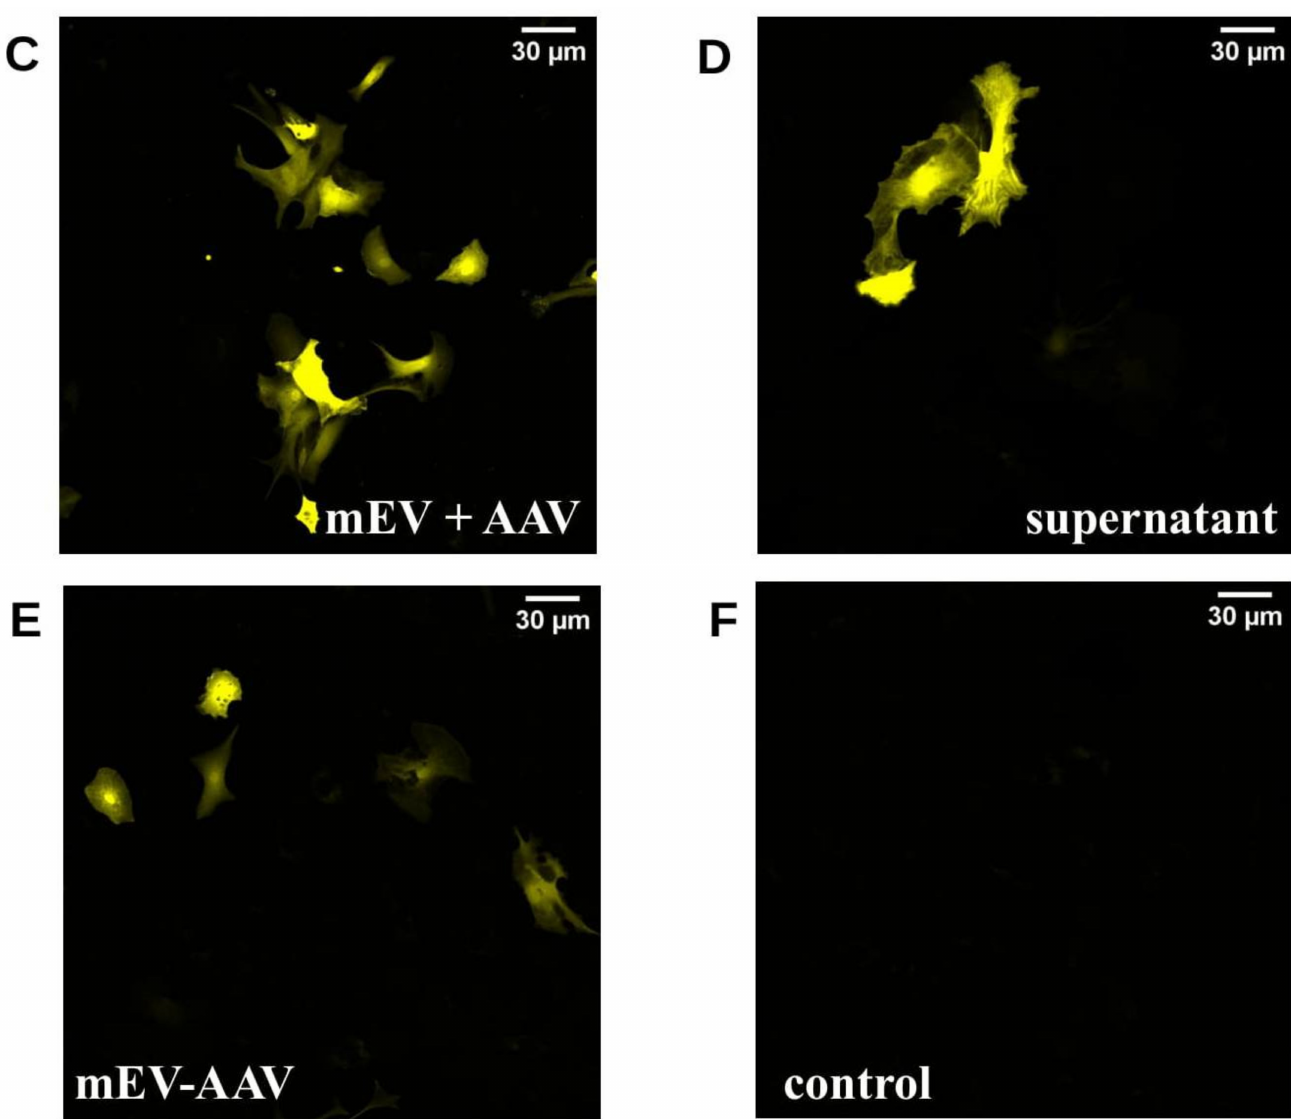
Figure 2. Confocal microscopic images of mouse astrocyte primary cell cultures 10 d after treatment. Astrocytes were trans- duced in vitro with different AAV treatments containing freshly prepared AAV and mEV combinations or complexes. ( A ) standard “AAV”, ( B ) “suspension” (a mixture of AAV and mEV), ( C ) “mEV + AAV” (co-centrifugation pellet of the previous suspension), ( D ) supernatant, ( E ) mEV-AAV (mEV-associated AAV released by AAV producing cells), ( F ) negative